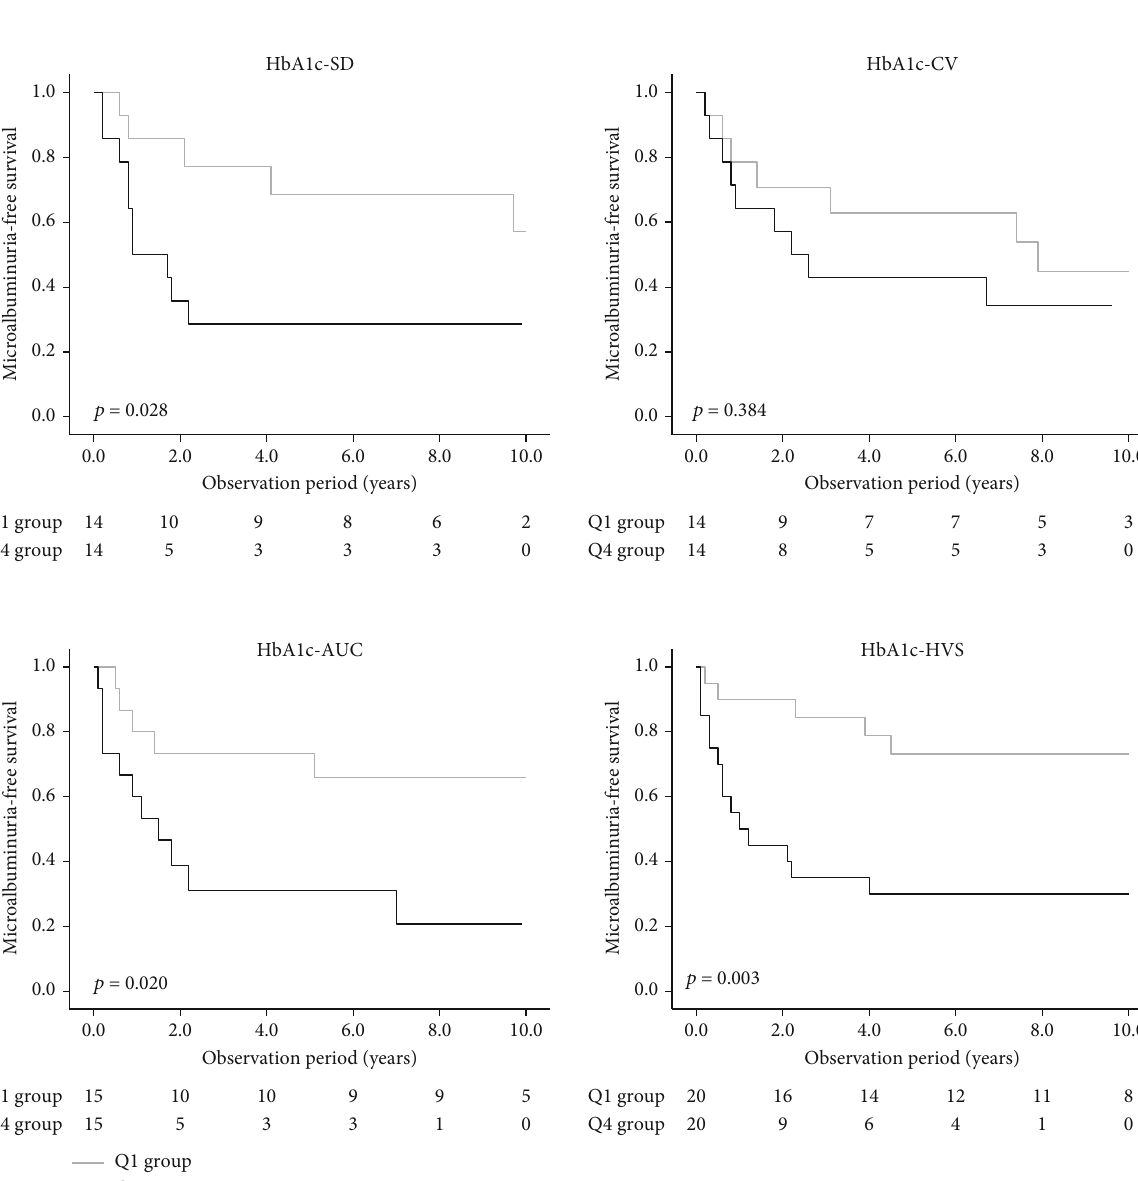
Figure 2: Kaplan-Meier curves for the microalbuminuria-free survival among PS-matched subjects from Q1 and Q4 group of each index of visit-to-visit variability of HbA1c. The lower quartile is denoted as Q1, and the upper quartile is denoted as Q4. The comparison of the cumulative incidence among groups was carried out using a log rank test. HbA1c-SD: internal standard deviation of HbA1c; HbA1c-CV: coe ffi cient of variation of HbA1c; HbA1c-AUC: area under the HbA1c curve; HbA1c-HVS: HbA1c change